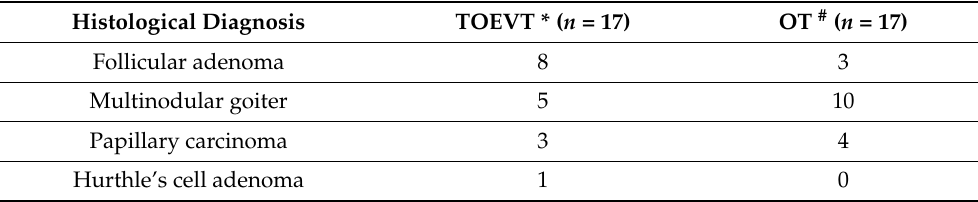
Table 6. Histological diagnoses of the thyroid glands in the transoral endoscopic vestibular and open thyroidectomy procedures after Propensity Score Matching ( n = 34).